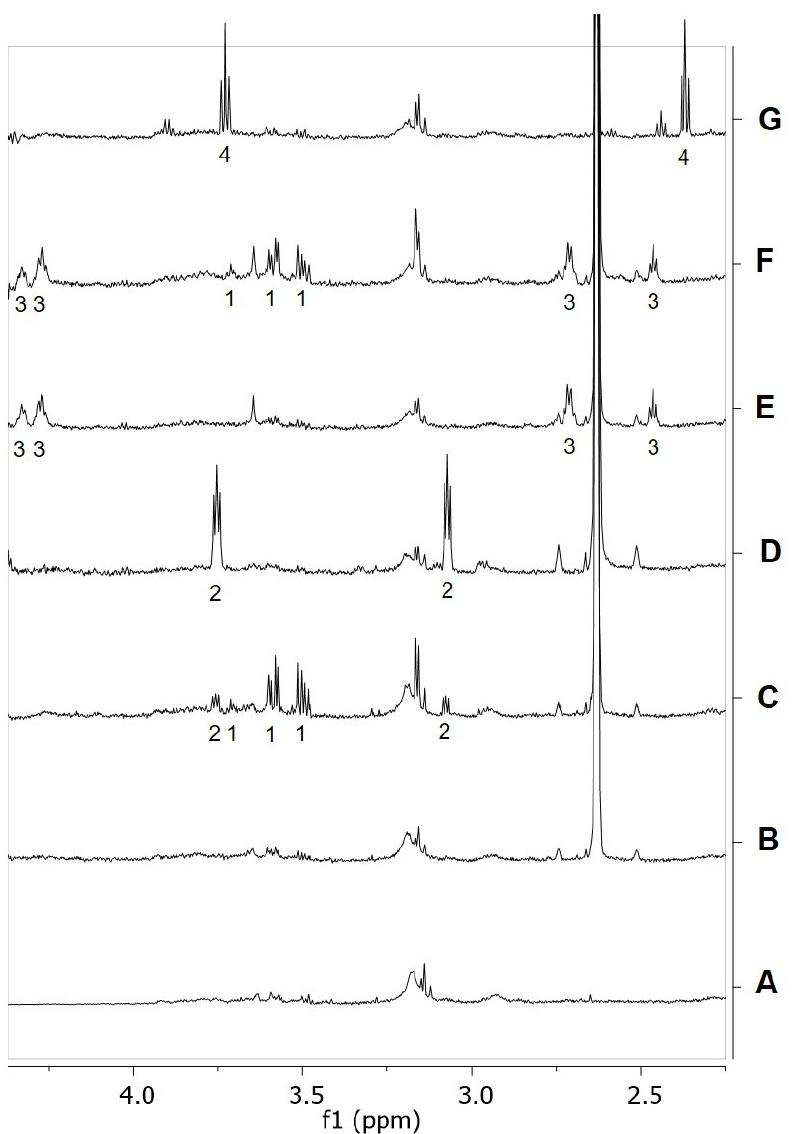
Figure 7. ( A ) 1 H NMR spectrum of a membrane sample dissolved in deuterated PBS, pH 7.4, 37 °C. ( B , C ) 1 H NMR spectra of the same sample after the addition of 1 mM PEA dissolved in d 6 ‐ DMSO. Number of scans (NS) = 64; spectrum B recorded at t = 0 s after PEA addition, spectrum C recorded after 12 h; ( D ) 1 H NMR spectrum of a membrane sample spiked with 0.1 mM ethanolamine (EA) dissolved in deuterated PBS, 10% d 6 ‐ DMSO, pH 7.4, 37 °C; ( E , F ) 1 H NMR spectra of the same sample after addition of 1 mM RePEA dissolved in d 6 ‐ DMSO; spectrum E recorded at t = 0 s after RePEA addition, spectrum F recorded after 12 h; ( G ) 1 H NMR spectrum of a membrane sample spiked with 0.1 mM 3 ‐ hydroxypropanoic acid (3 ‐ HPA) dissolved in deuterated PBS, 10% d 6 ‐ DMSO, pH 7.4 37 °C. PEA